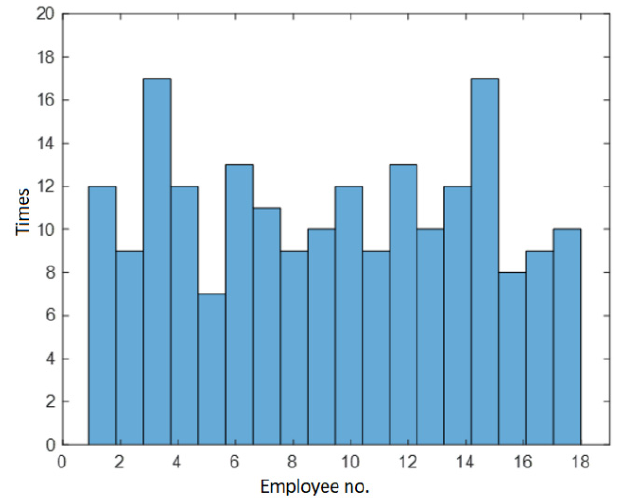
Figure 14. Number of absences after 200 program activations.